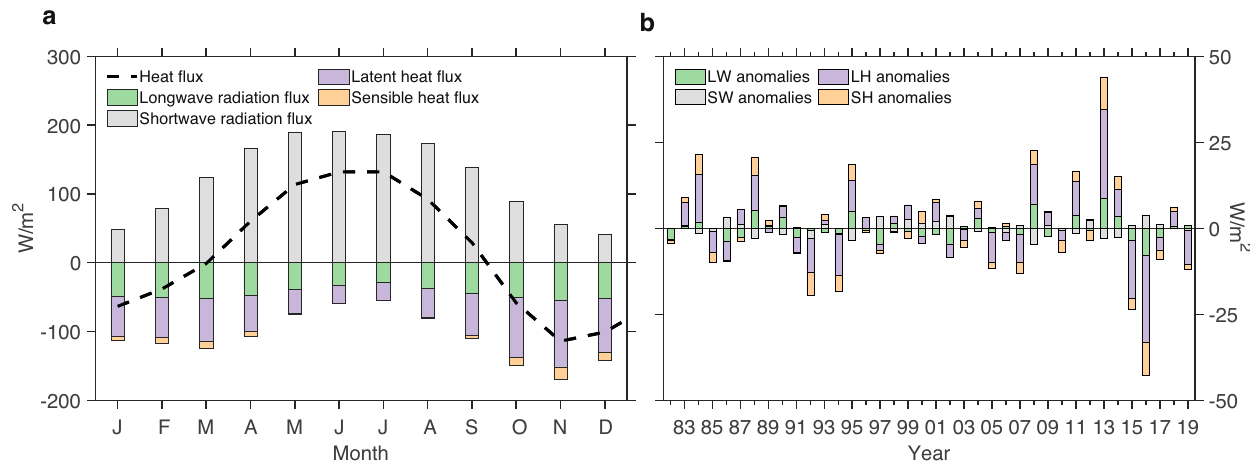
Fig. 4 Climatology and anomaly of the air-sea heat fl ux. a Climatological monthly mean of air-sea heat fl ux (dashed black line), longwave radiation (LW, green bar), shortwave radiation (SW, gray bar), and latent (LH, purple bar) and sensible (SH, orange bar) heat fl uxes. b The values of air-sea heat fl ux anomalies and their four components in winter (October – January) from 1982 to 2019. The positive heat fl ux represents the heat into the upper ocean.